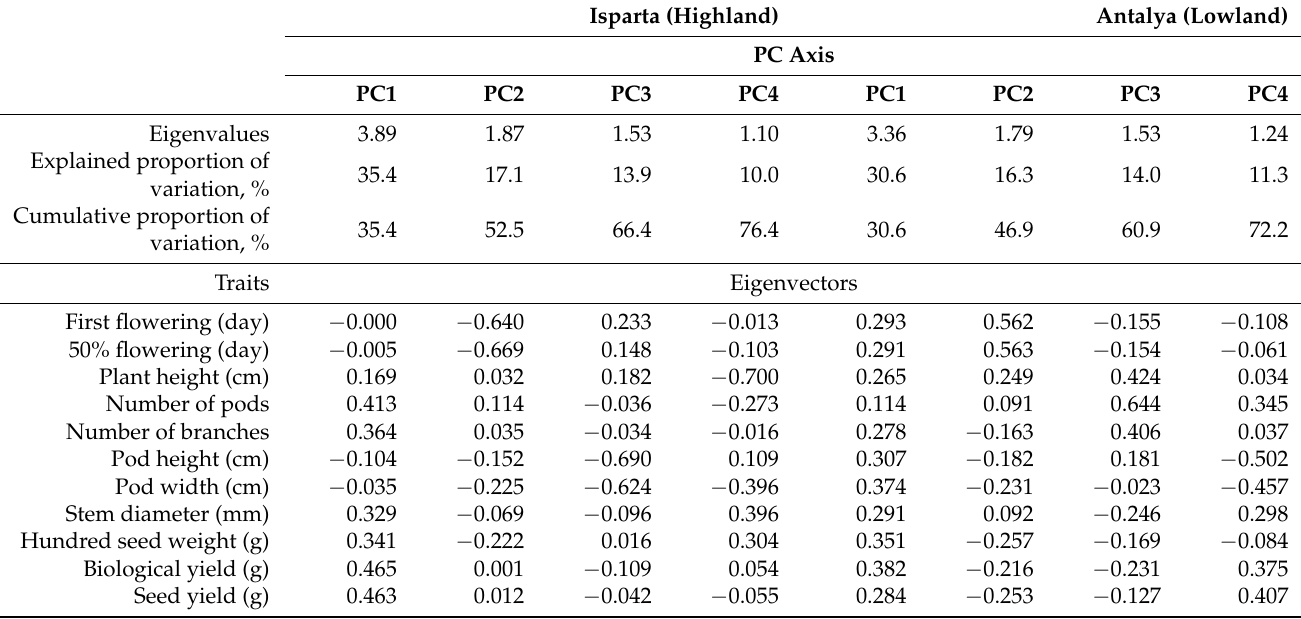
Table 3. Eigenvectors for the four principal components (PCs) of traits associated with agronomic performance of 94 grass pea genotypes produced in two different